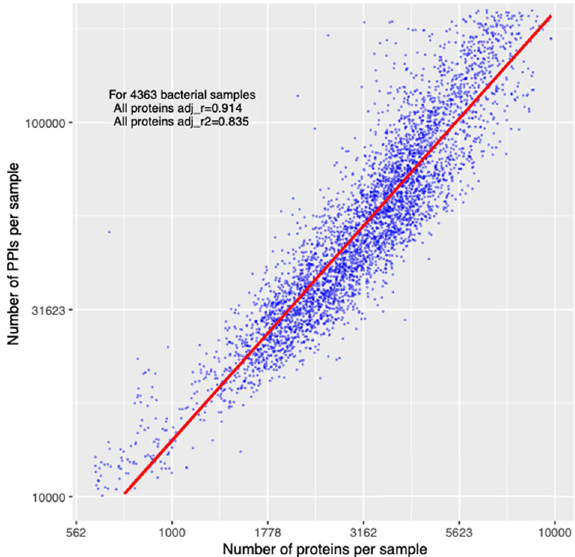
Figure 2. The number of proteins per bacterial genome (x-axis) was highly predictive of the number of PPIs (y-axis) (adjusted r 2 = 0.835). The data was for 4363 bacterial samples, each of which is shown by a blue dot, with a linear model line of best fit shown in red.